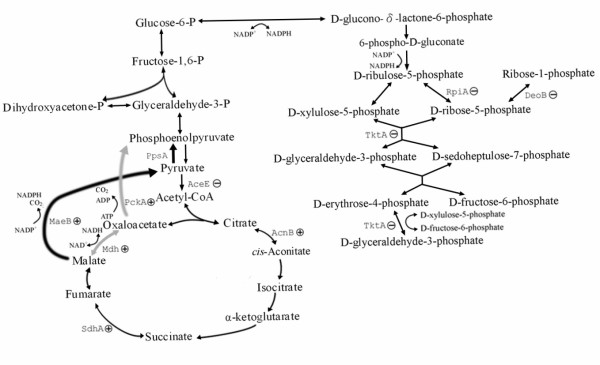
The glycolytic pathway, the gluconeogenic pathway, the TCA cycle, and the pentose phosphate pathway in E. coli cultured in LB medium. Up- and down-regulated proteins resulting from the proteome profiling are marked with ⊕ and ⊖, respectively.